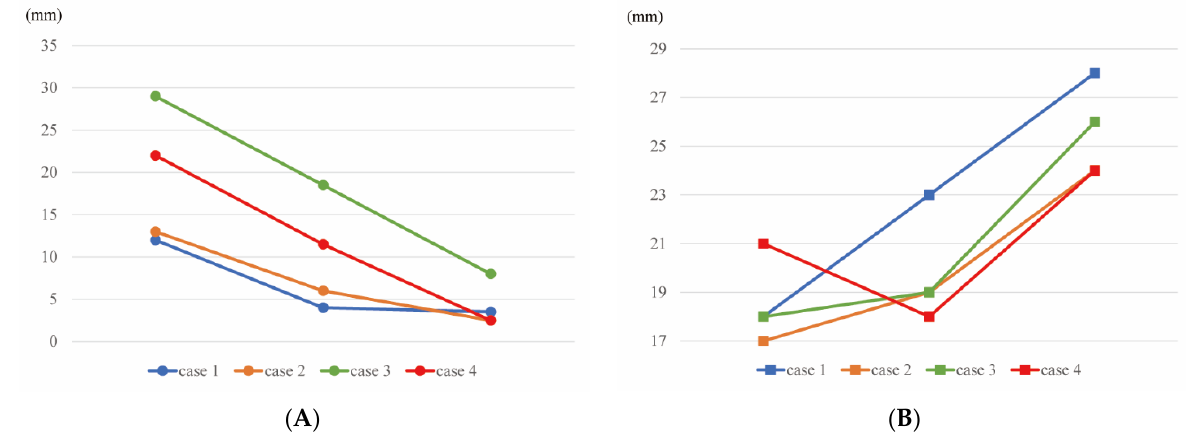
Figure 3. Trends in the summation of the R waves in the V1–3 leads on electrocardiography and the sums of the septal and posterior wall thickness on echocardiography for four ATTR-CM cases (additional three cases and the main case). ( A ) The sum of R amplitudes of V1, V2 and V3 on electrocardiograms. ( B ) The sums of the septal and posterior wall thickness on echocardiography. ( A , B ) The 1st point: baseline; 2nd point: time when the ECG change appeared; 3rd point: time when increased ventricular thickness appeared clearly on echocardiography in the 4 cases of ATTR-CM. Panel ( A ) shows a significant difference between the 1st and 2nd points; however, panel ( B ) does not. Both panels show a significant difference between the 1st and 3rd points.